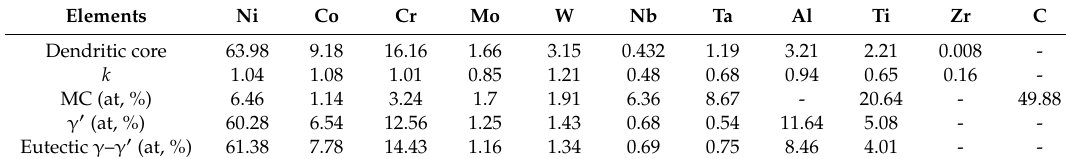
Table 4. Chemical composition of precipitates in the AF sample by EDS. Elements